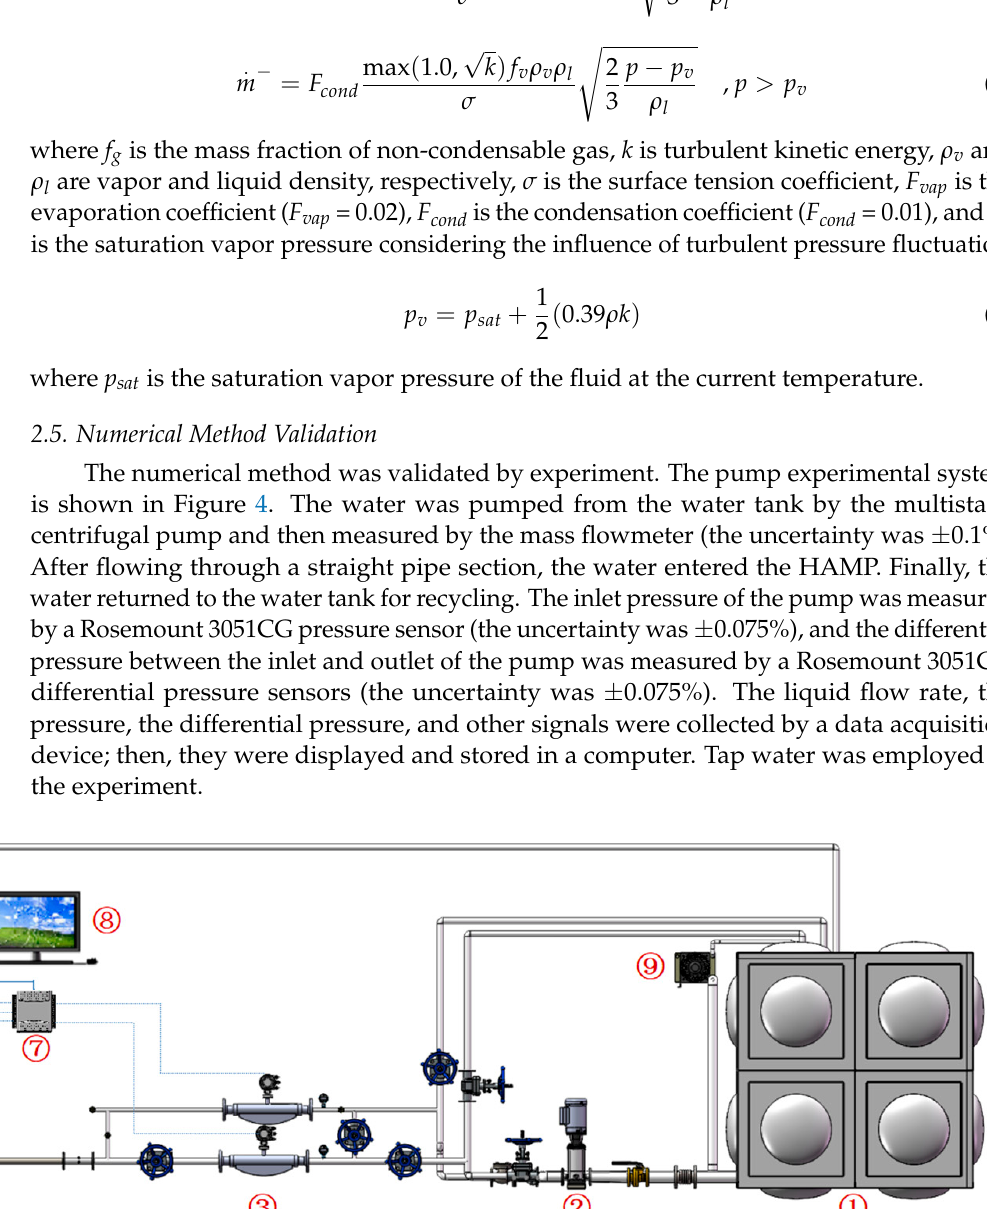
Figure 5. Water head comparison between simulation and experiment . 3. Results and Discussions 3.1. Cavitation Characteristic Curve of HAMP The Net Positive Suction Head ‐ available (NPSHA) is calculated by Equation (5): in